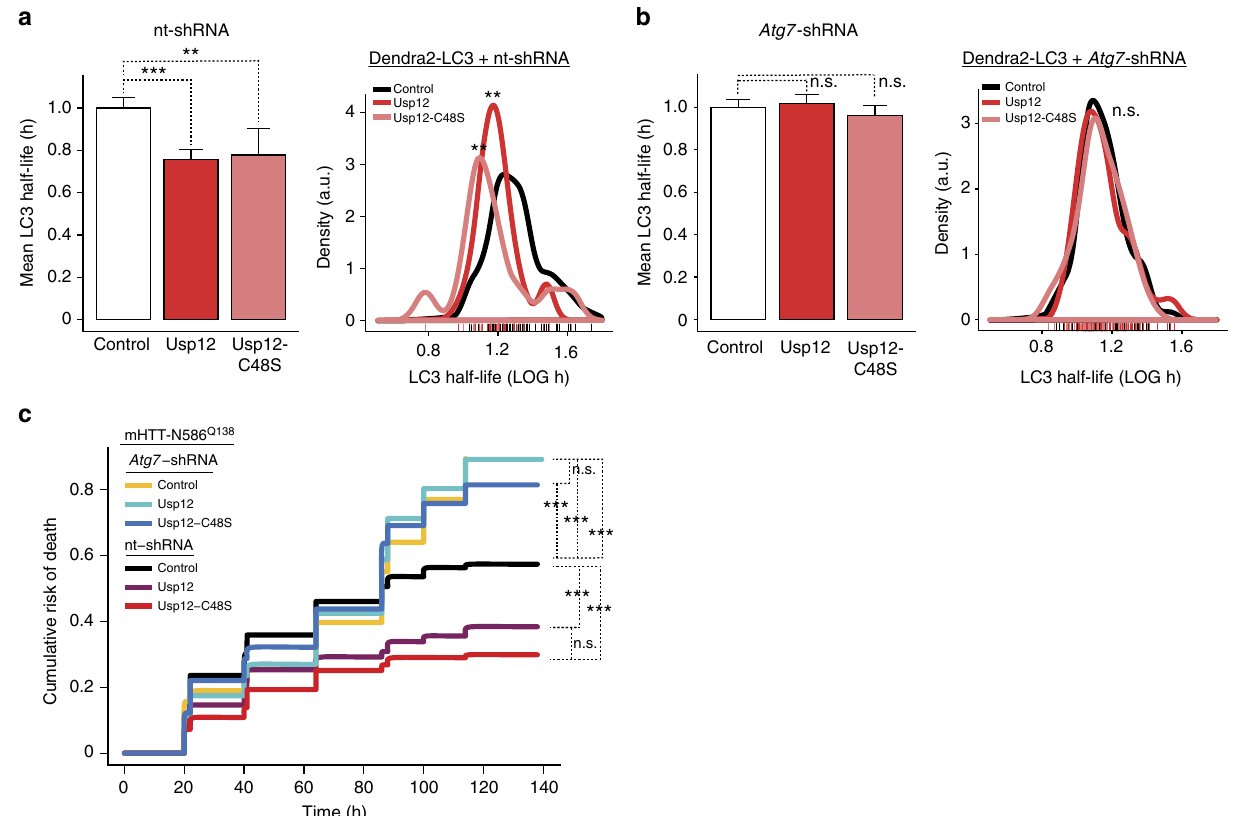
Fig. 7 Usp12 function in LC3 turnover and mHTT-mediated toxicity is impaired in neurons genetically depleted of Atg7. a , b LC3 half-life was measured in neurons co-transfected with nt-shRNA or Atg7 -shRNA, Usp12, Usp12-C48S, or control plasmids, and Dendra2-LC3 using the optical pulse-labeling assay described above. P value for mean half-life and distributions determined by Mann-Whitney and Kolmogorov-Smirnov tests, respectively. Error bars represent s.e.m. (** p < 0.01, *** p < 0.001). c Cumulative risk of death plots for neurons co-transfected with toxic mHTT and Usp12 overexpression or shRNA plasmids. Usp12 and Usp12-C48S do not effect neuroprotection during inhibition of Atg7-dependent autophagy. Cox proportional hazards analysis was used to estimate the relative risk of death, or hazard ratio (HR) and the p values were determined with the log rank test (*** p < 0.001)